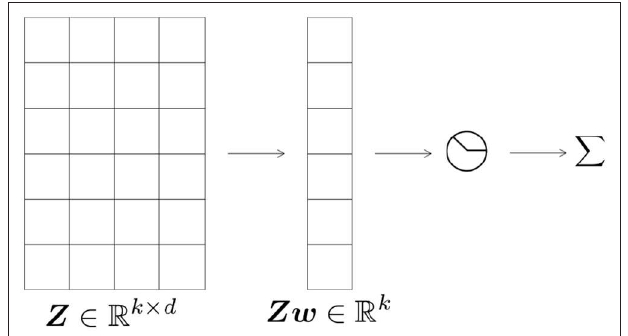
FIGURE 1 | The architecture of a no-overlap neural